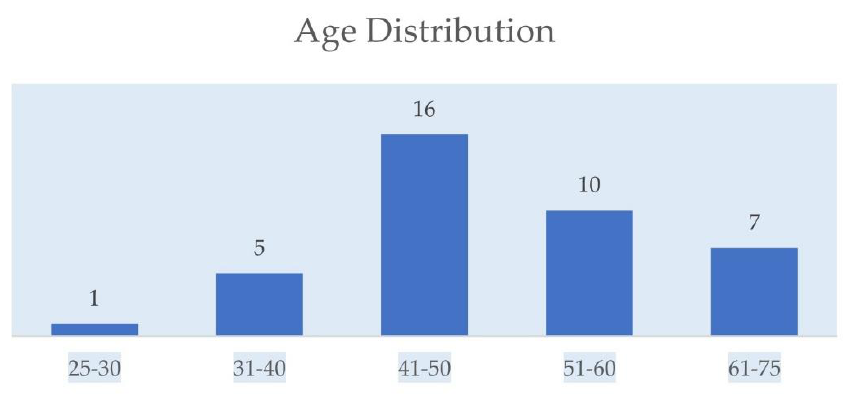
Figure 13. Age distribution of respondents.